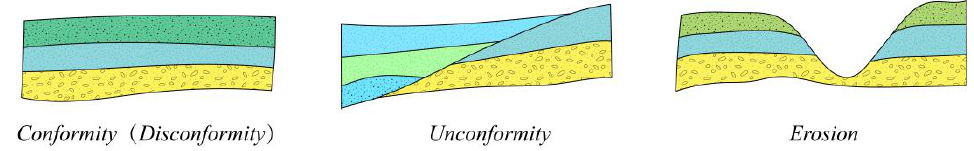
Figure 3. Four types of contact relationships of Quaternary strata.